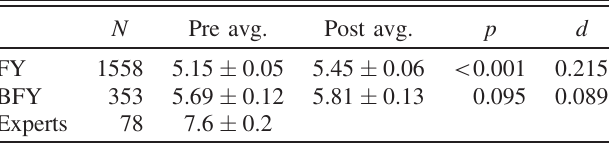
TABLE VIII. Average scores across levels of physics maturity, where N is the number of matched responses, except for experts who only filled out the survey once. Significance levels and effect sizes are reported for differences between the pre- and post- survey means.